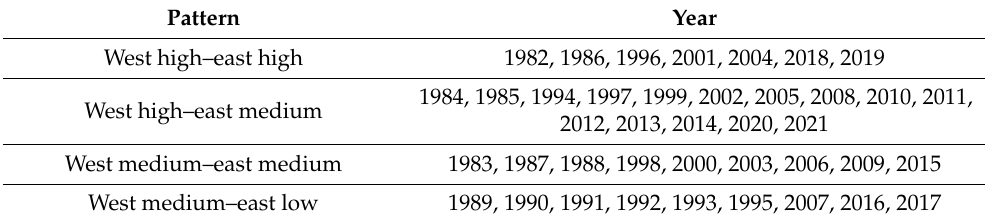
Table 4. The frontal frequency patterns in the west and east of YSRF.